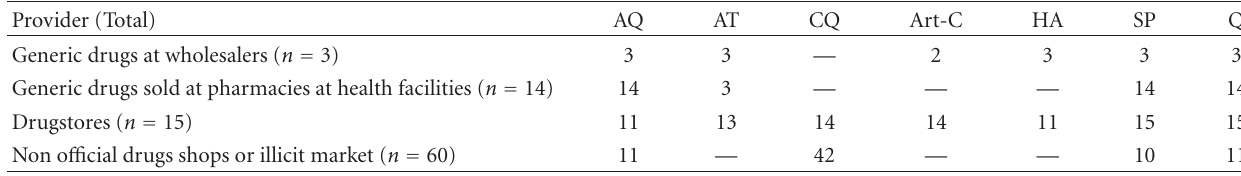
Table 2: Number of providers of antimalarial drugs in Bangui, May to July 2006